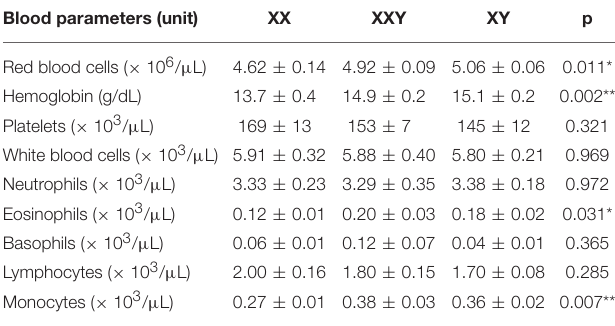
TABLE 1 | Mean ± SEM for complete blood count ( n = 17).